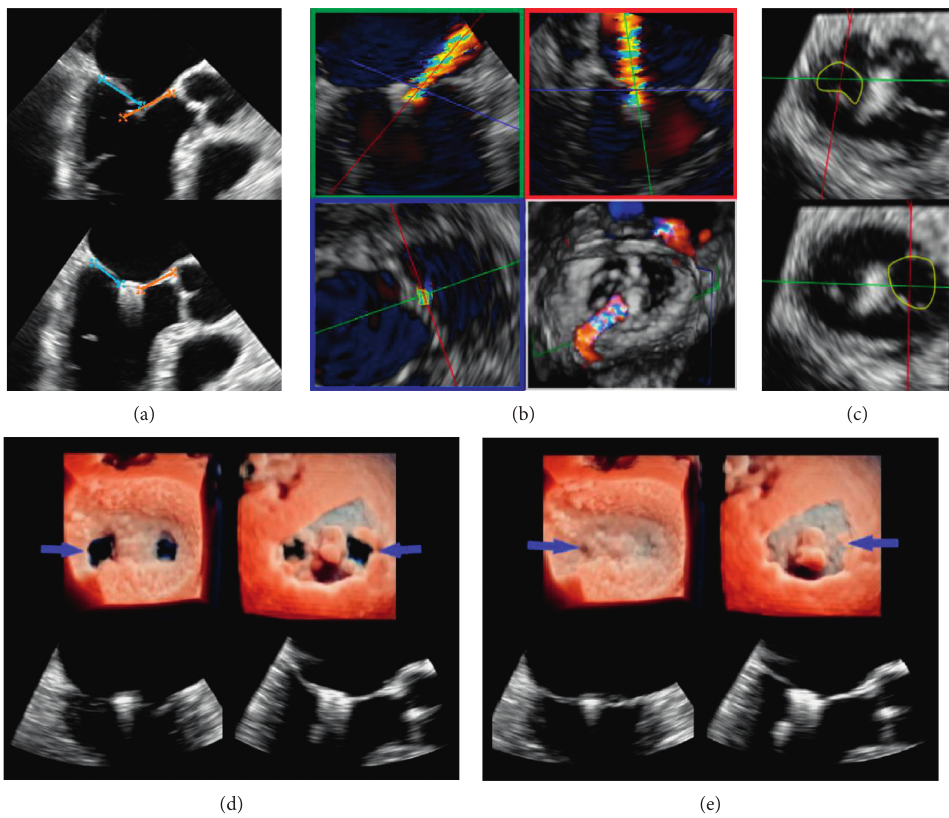
Figure 5: Valve function assessment. (a) The length of leaflet insertion can be calculated, which equals the difference between the length of leaflets before and after grasping. (b) Planimetry of vena contracta (VC) area in a wall-hugging residual regurgitant jet. (c) Using multiplanar reformatting, planimetry of each residual orifice will allow for the calculation of cumulative MVA to exclude mitral valve stenosis. Each orifice should be measured in separate planes as they are not in the same plane. (d, e) The newly created double orifices are assessed by 3D zoom MV enface LA and LV view+X-plane view in the systolic frame (d) and diastolic frame